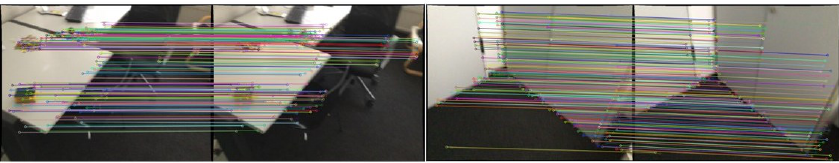
Figure 6. Matching result from